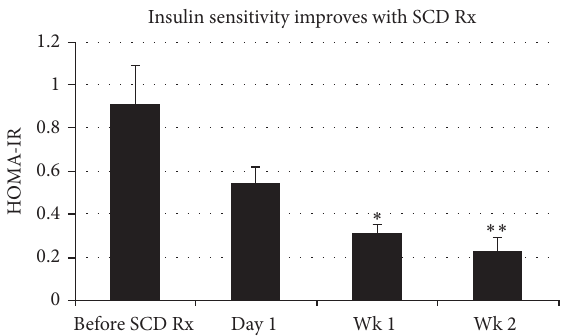
Figure 4: A progressive decrease in HOMA-IR scores reflective of improved insulin sensitivity was observed with SCD Rx. HOMA- IR scores trended lower 1-day post-SCD Rx course and were significantly lower at 1 week and 2 weeks after Rx course monitoring periods. Average of 3 SCD Rx courses that each consisted of three 6- hour SCD treatments in one week is shown ± SE ( 𝑛 = 3 ). 𝑝 = 0.031 ( ∗ ) and 𝑝 = 0.016 ( ∗∗ ) for pre-SCD Rx course versus week 1 and week 2 post-Rx course.